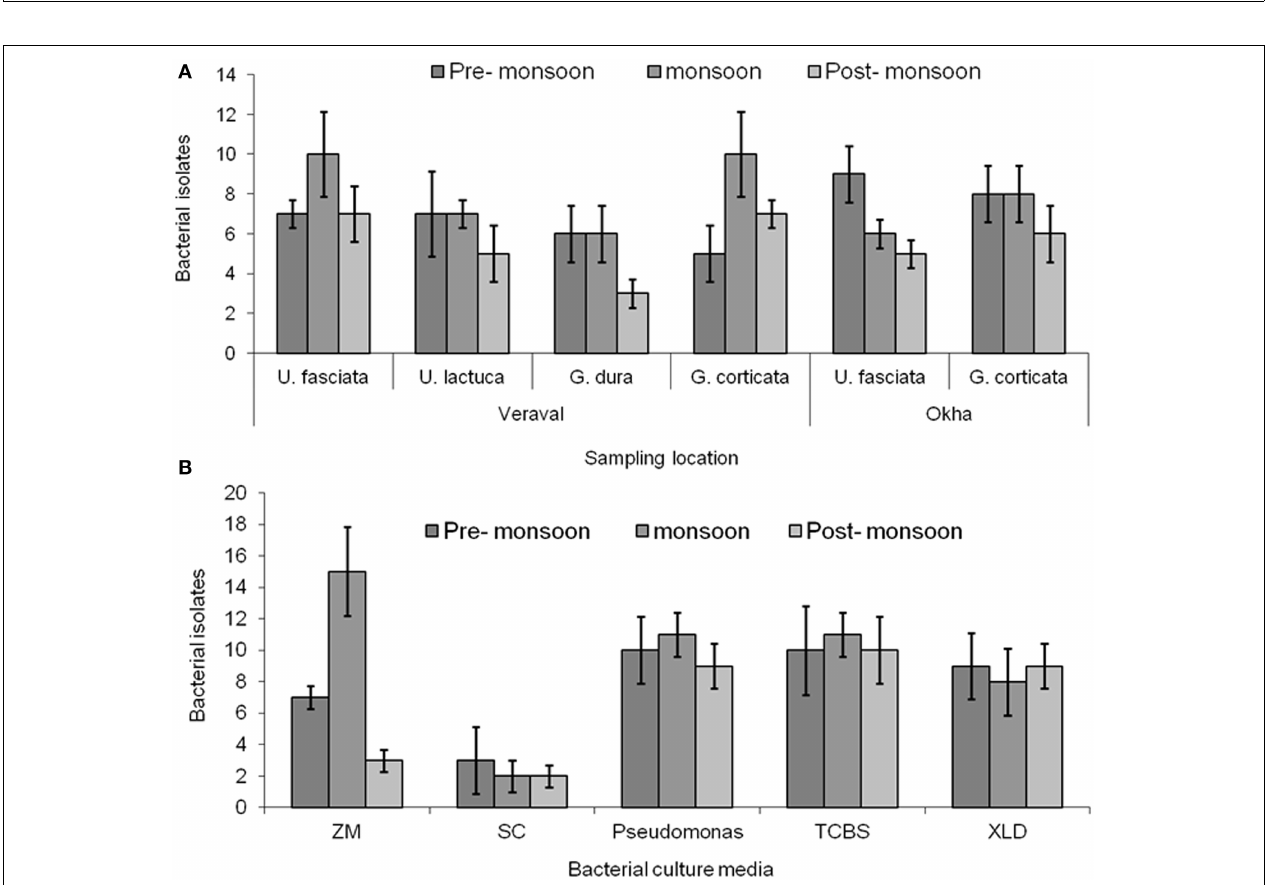
EFFECT OF DIFFERENT AHLs ON CARPOSPORE LIBERATION FROM G. DURA AHL containing culture filtrates of seven Gram-negative bacte- ria and the AHL standards of C 4 - and C 6 -HSL were found to induce the liberation of carpospores in G. dura as compared to the control and the C 10 -, 3-oxo-C 12 -HSL, and culture filtrates of B. flexus . There was a positive correlation between different concentrations (2, 4, 6, 8, and 10 μ M) of the C 4 - and C 6 -HSL and carpospore liberation from the cystocarps ( Figure 5A ).